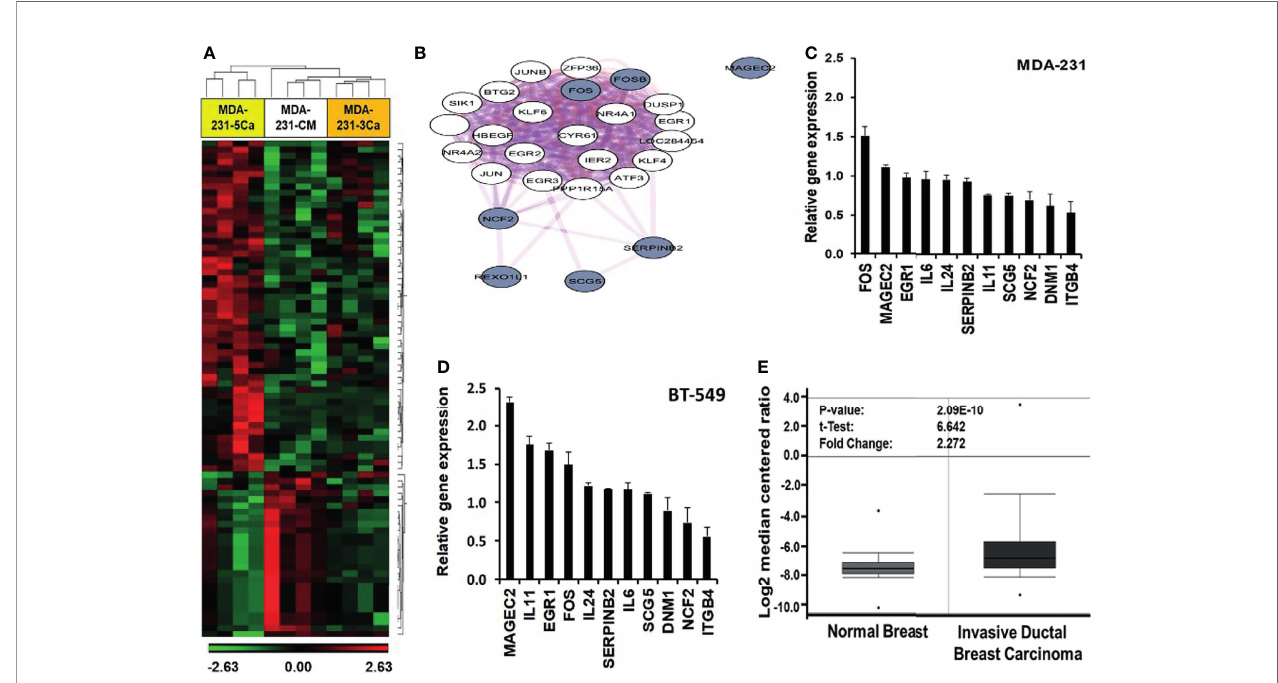
FIGURE 3 | Induction of early response and malignancy associated genes as a response of breast cancer cells to sustained high Ca 2+ . (A) Heatmap of Gene expression pro fi ling of high Ca2+ treated MDA-MB-231 cells. (B) Biological network relationship of up regulated (high Ca2+ inducible) genes (hashed nodes), pink edges are physical interactions and purple edges are co-expression associations (https://genemania.org/). (C, D) Validation of high Ca 2+ inducible genes by RT-PCR in MDA-MB-231 (C) and BT-549 (D) TNBC cells. (E) Expression of MAGEC2 in normal breast (n = 61) and invasive ductal breast carcinoma (n = 396) was analyzed in the TCGA Breast dataset in